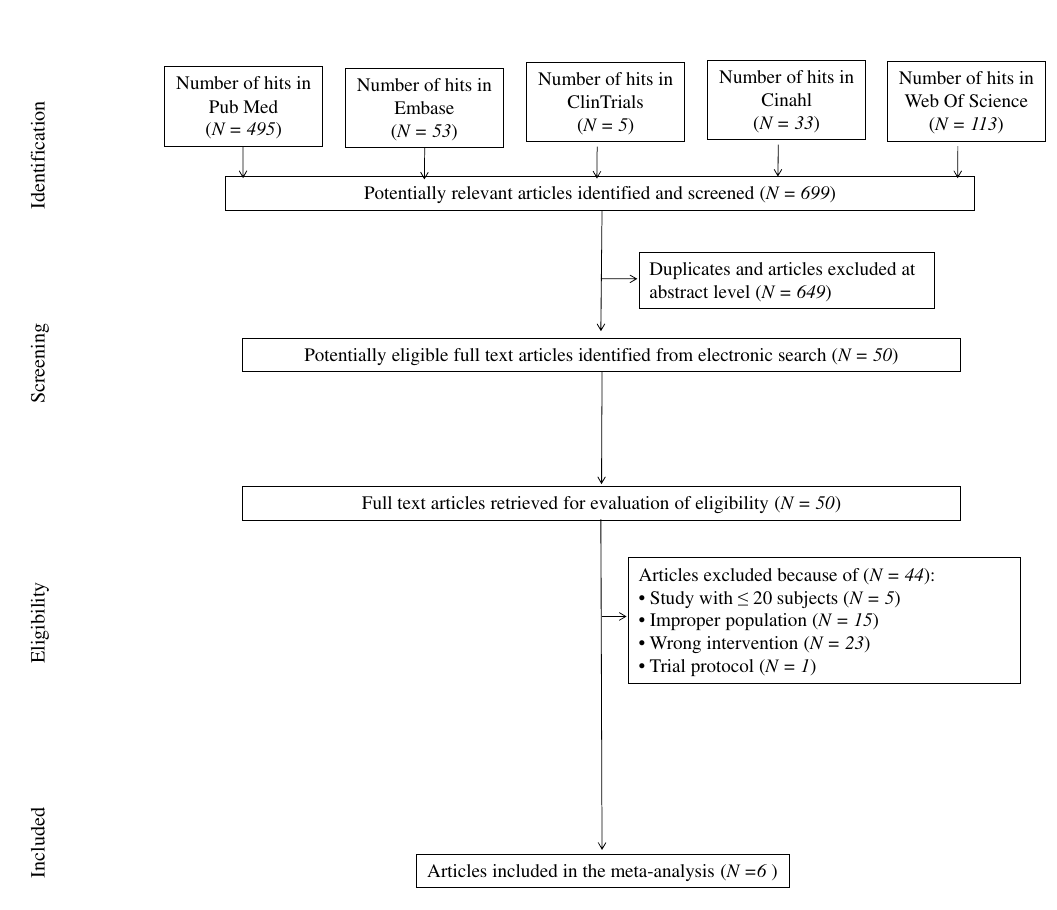
Figure 1. Study flow